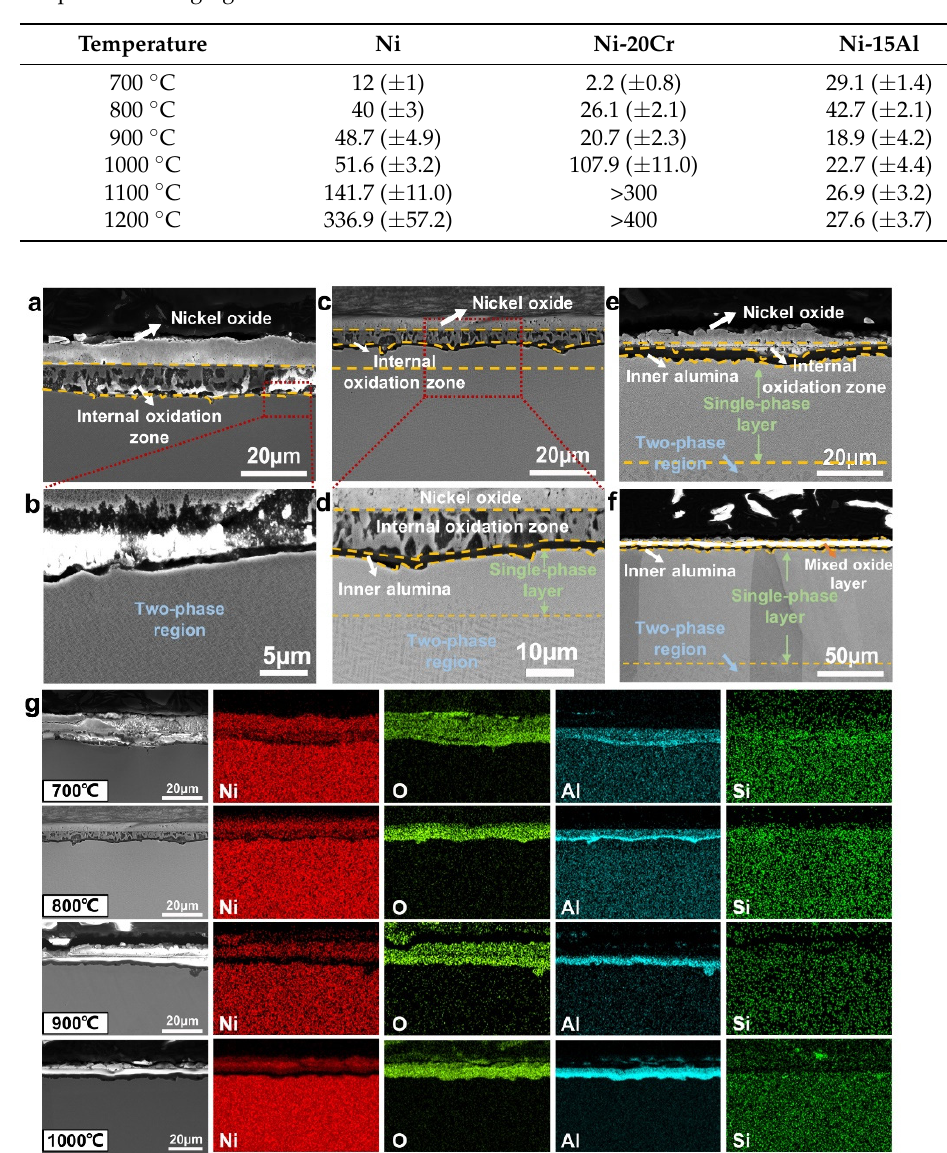
Figure 6. Cross-sectional microstructure (SE images) of oxide scales on Ni-15Al-2Si alloy oxidized at various temperatures for 576 h. ( a , b ) 700 °C; ( c , d ) 800 °C; ( e ) 900 °C; ( f ) 1000 °C. ( g ) EDS maps of oxide scales on Ni-15Al-2Si at temperatures ranging from 700 °C to 1000 °C.